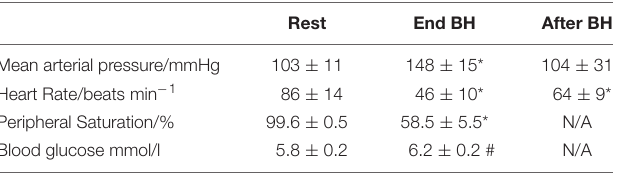
Table 2 , P < 0.001), while blood glucose increased from 5.8 ± 0.2 TABLE 2 | Peripheral saturation, blood glucose, heart rate, and mean arterial blood pressure during pool apnea. Rest End BH After BH